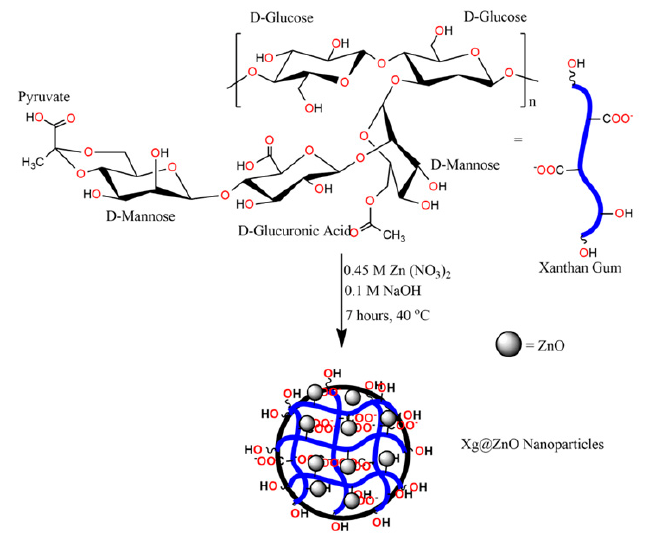
Figure 2. Proposed scheme for the synthesis of ZnO@XG nanocomposite.